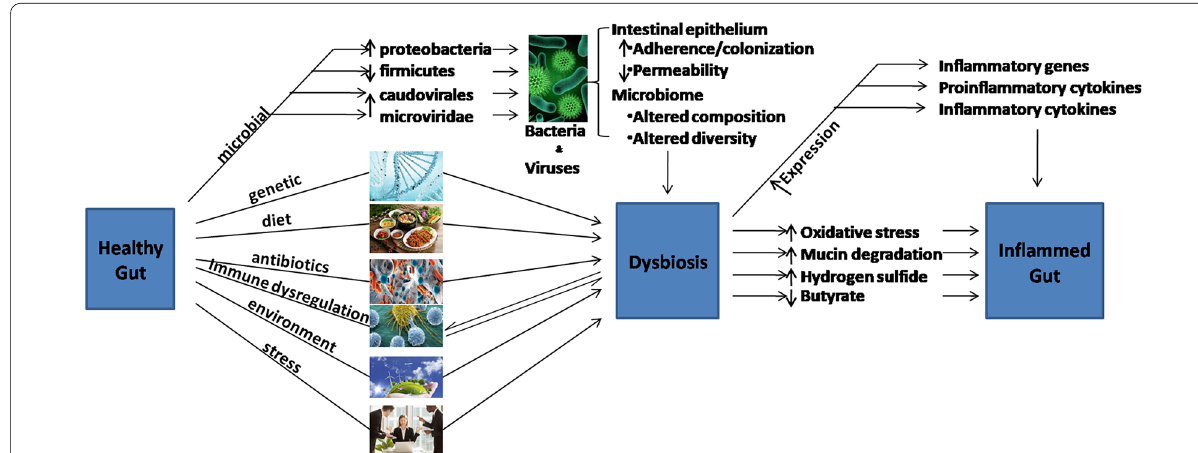
Fig. 1 The road of a healthy gut to an inflamed gut. Many factors are associated with the alteration of gut microbiome which ultimately lead to dysbiosis. The altered microbiota diversity and composition coupled with other intestinal epithelial changes lead to inflammation in the gut, characterized by increased inflammatory genes